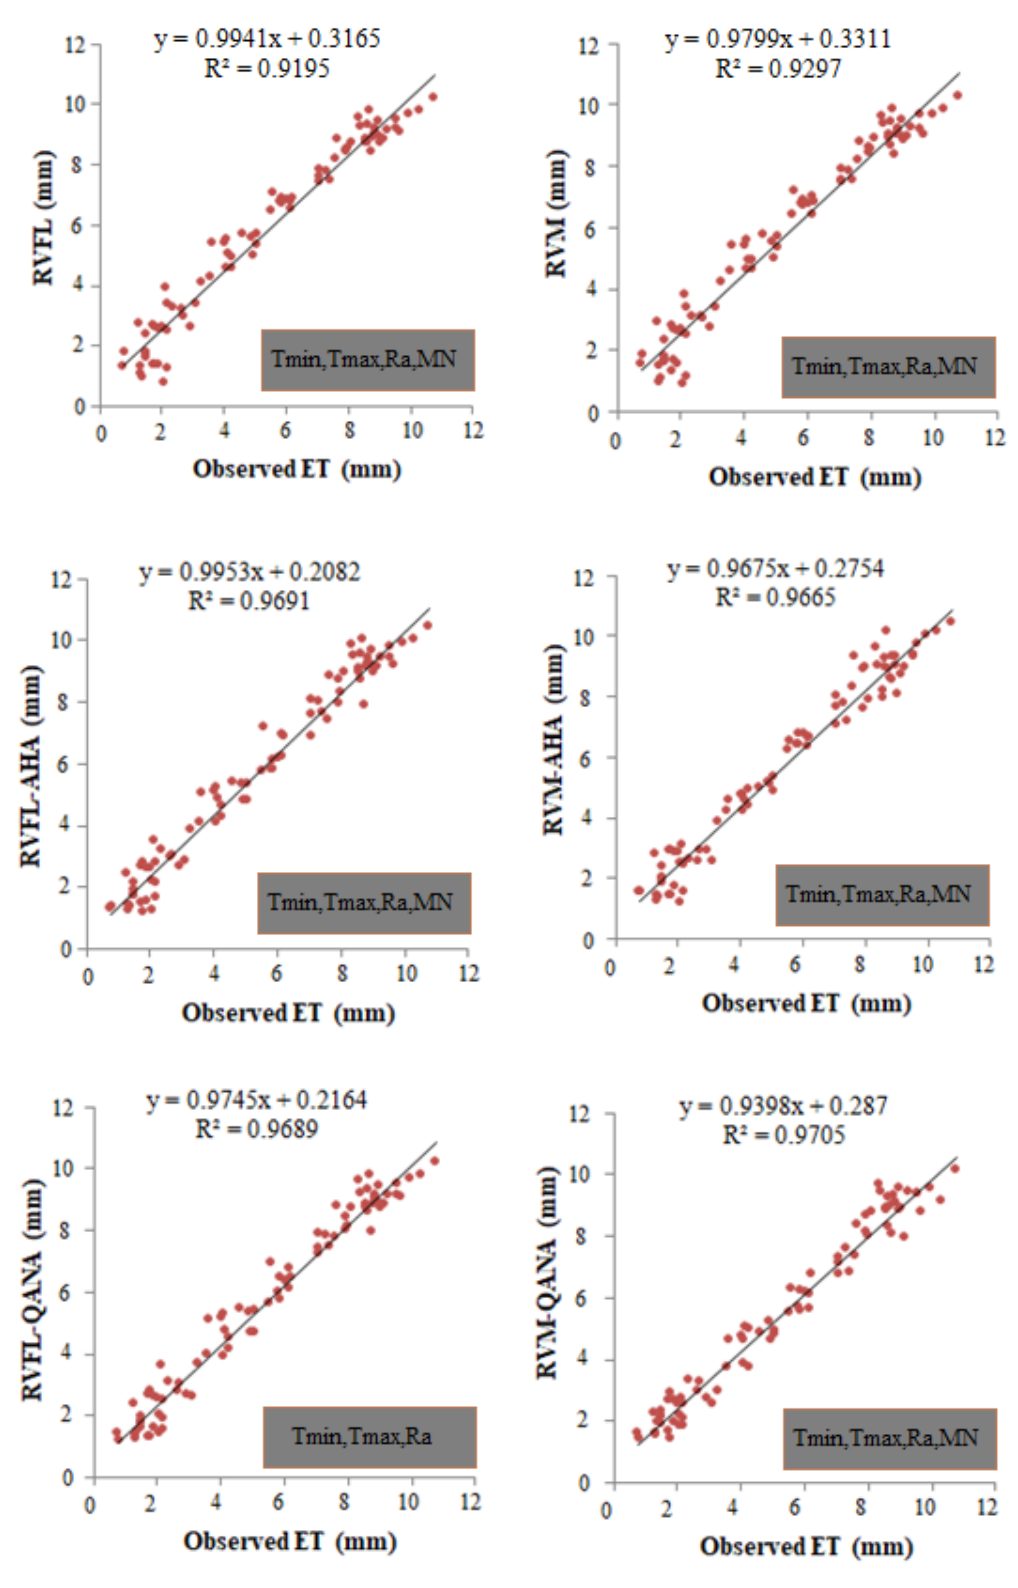
Figure 9. Scatterplots of the observed and predicted ET by different RVFL‑ and RVM‑based models in the test period using the best input combination –Station 2 (Peshawar).